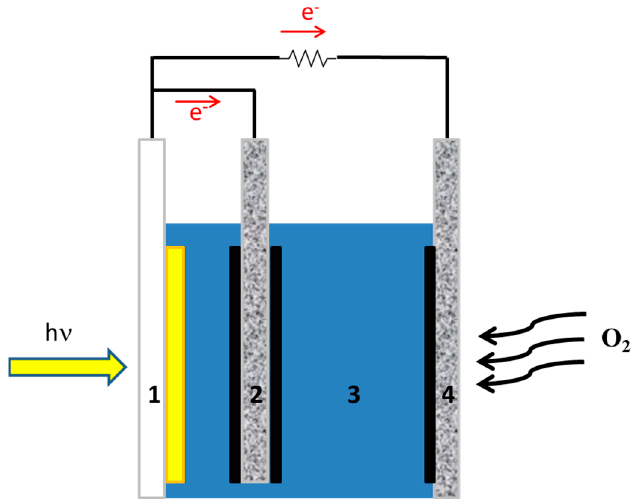
Figure 1. Illustration of the device with supercapacitor: (1) transparent FTO electrode carrying photocatalyst (yellow part); (2) supercapacitor electrode loaded with biochar (solid black); (3) electrolyte; (4) gas diffusion counter electrode carrying electrocatalyst (solid black).